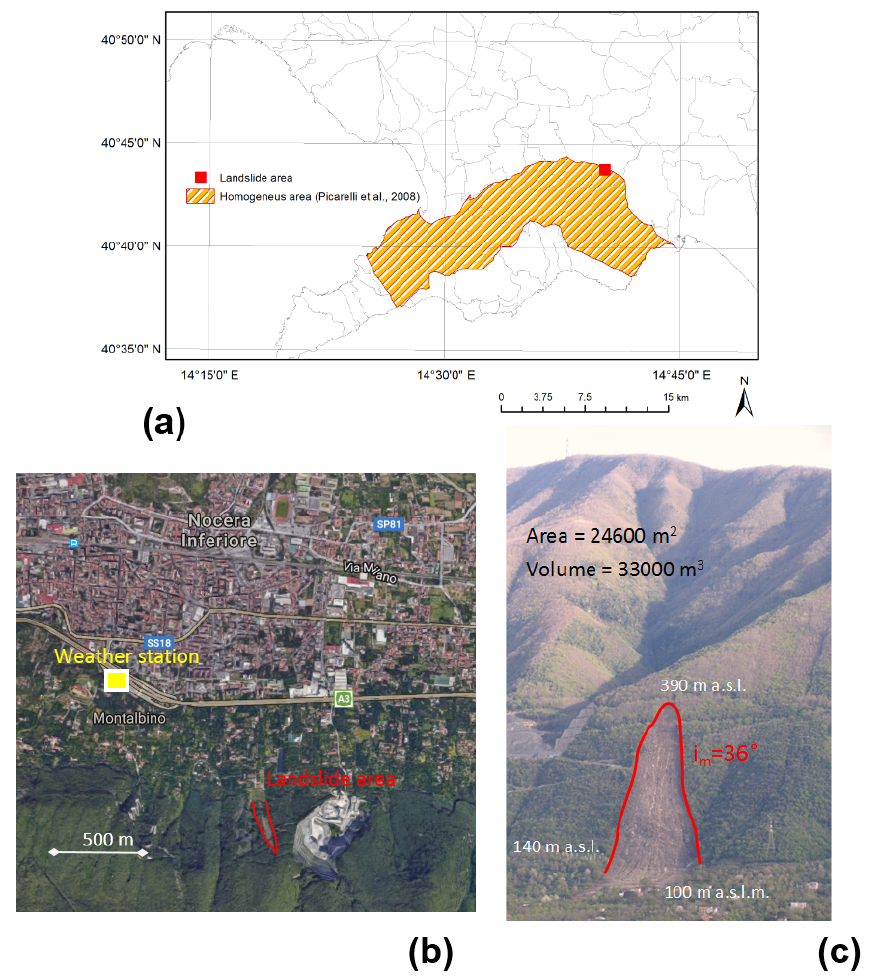
Figure 1. The 2005 Nocera Inferiore Landslide (2005NIL): (a) map indicating the landslide location and zones homogeneous with that of the landslide for soils, cover thicknesses and slope gradients; (b) plan view (DigitalGlobe 2012, http://www.earth.google.com), indicating the landslide area and the location of the weather station; (c) frontal view of the landslide area (Pagano et al., 2010,